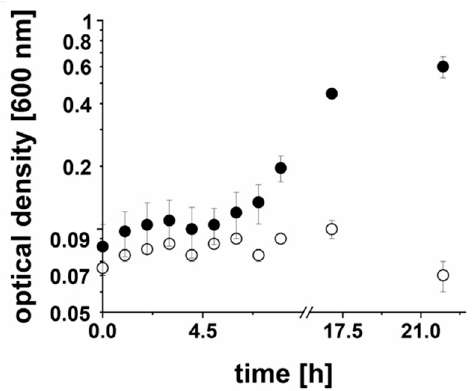
Figure 2. Growth of P. bivia is dependent on CO 2 . Cells of P. bivia were cultivated in medium prepared with CO 2 (back circles) or with N 2 (white circles). Average and standard deviation of three biological replicates are shown.